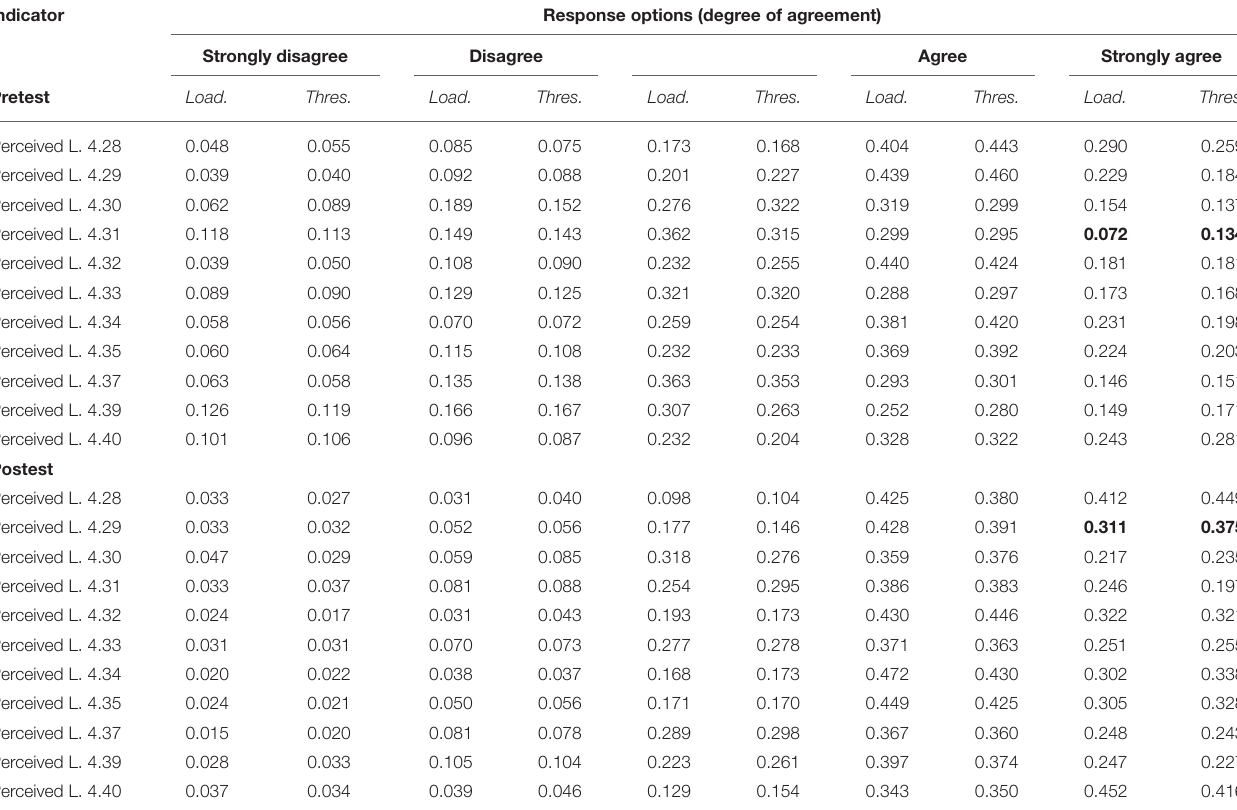
TABLE 6 | Estimated probabilities for the metric invariance and strong invariance models. Indicator Response options (degree of agreement) Strongly disagree Disagree Agree Strongly agree Pretest Load. Thres. Load. Thres. Load. Thres. Load. Thres. Load.